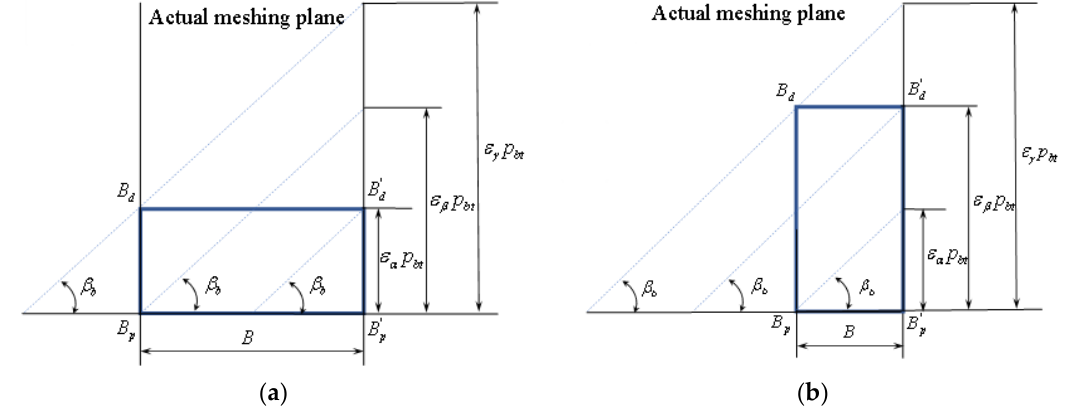
Figure 2. Length of contact line in meshing plane of helical gear: ( a ) ε α ≤ ε β ; ( b ) ε α > ε β .